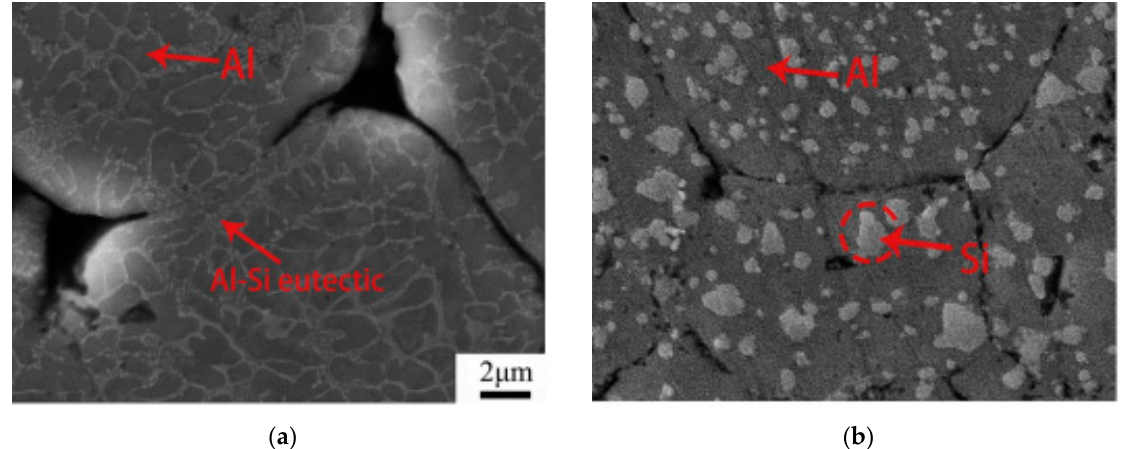
Figure 11. Consolidation of Al-12Si powders: ( a ) by EDC, with the original eutectic structure being maintained; ( b ) by spark plasma sintering (SPS), with the original microstructure being changed. Reprinted with permission from ref. [77] Copyright 2020 Elsevier.